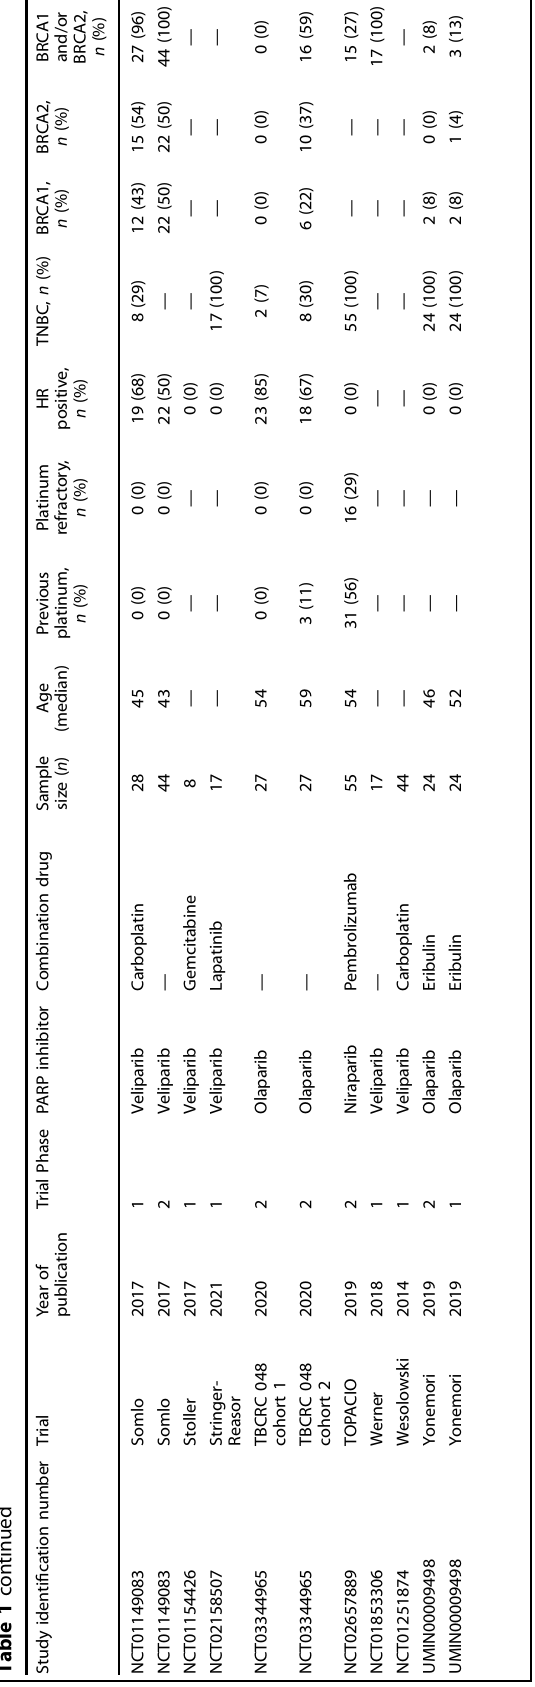
Fig. 2b). Compared to chemotherapy alone, patients rando- mized to PARPi had non-signi fi cantly higher odds of experiencing ORR (OR 1.62, 0.66-3.98, p = 0.30, Fig. 2c) as statistically signi fi cant heterogeneity for ORR (Cochran ’ s Q pooled results. Of note, the veliparib and temozolomide (VT) arm of the BROCADE trial 13 was a source for heterogeneity. As such, data for this treatment were excluded in a sensitivity analysis. Results showed statistically signi fi cant PFS and non-signi fi cant